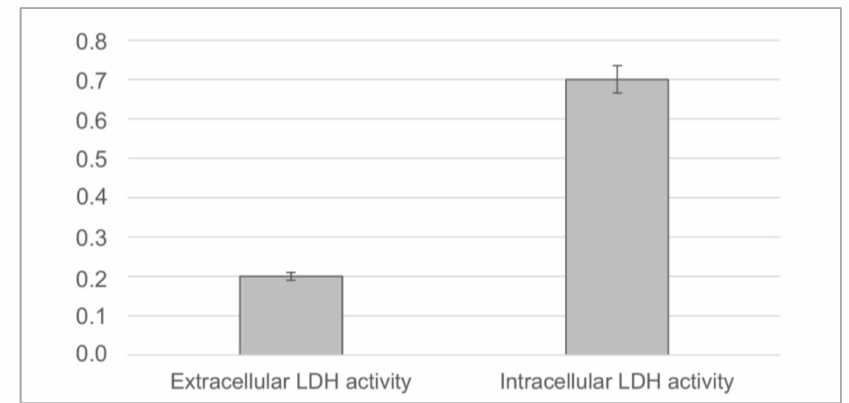
Figure 7. Cytotoxicity assay of mesenchymal stem cells (MSCs) cultured on CaO.TiO 2 .SiO 2 . Lactate dehydrogenase (LDH) leakage was measured at 7 days and reported as the optical density (OD) 490 nm / 104 viable cells. The results are the mean of 2 samples from 3 di ff erent experiments ± SD. * p <